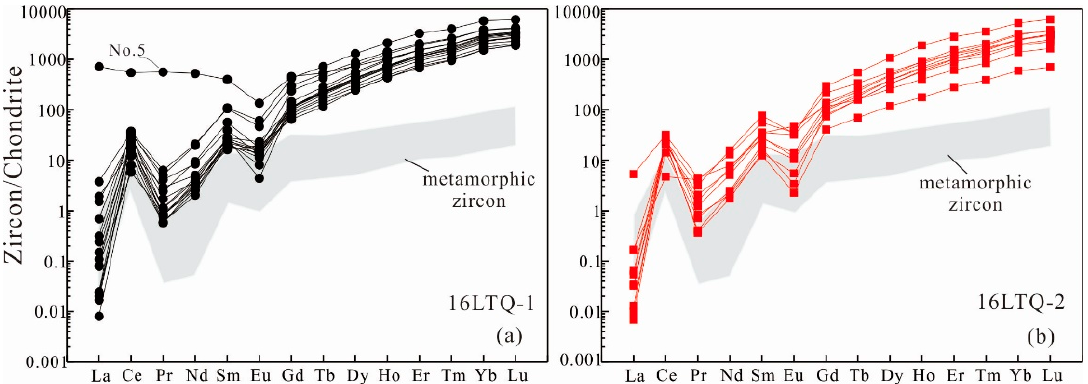
Figure 5. Zircon chondrite-normalized REE diagrams of the two samples ( a ) 16LTQ-1 and ( b ) 16LTQ-2. Chondritic values are from [80]. The detailed data of metamorphic zircons come from [77].